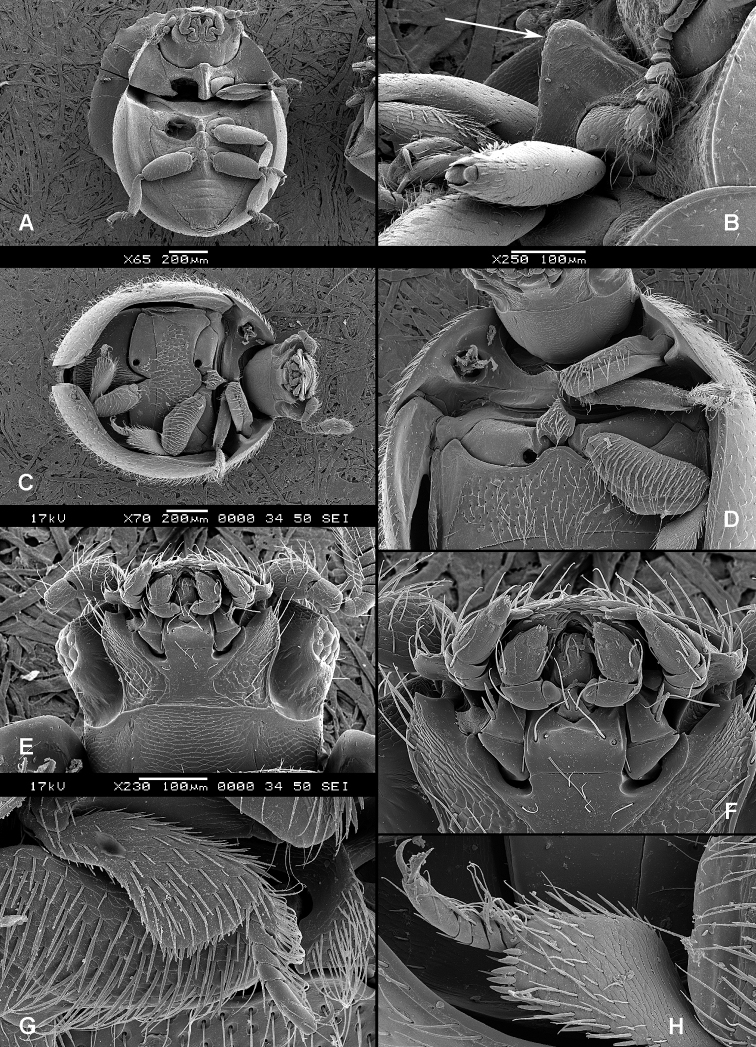
A–B “Rentonellum” loebli (A ventral surface B prosternal intercoxal process) C
cf. Globorentonium plaumanni, Brazil (C ventral surface D pro- and mesothorax ventrally E head ventrally F detail of mouthparts G protibia with tarsus H mesotibia with tarsus).